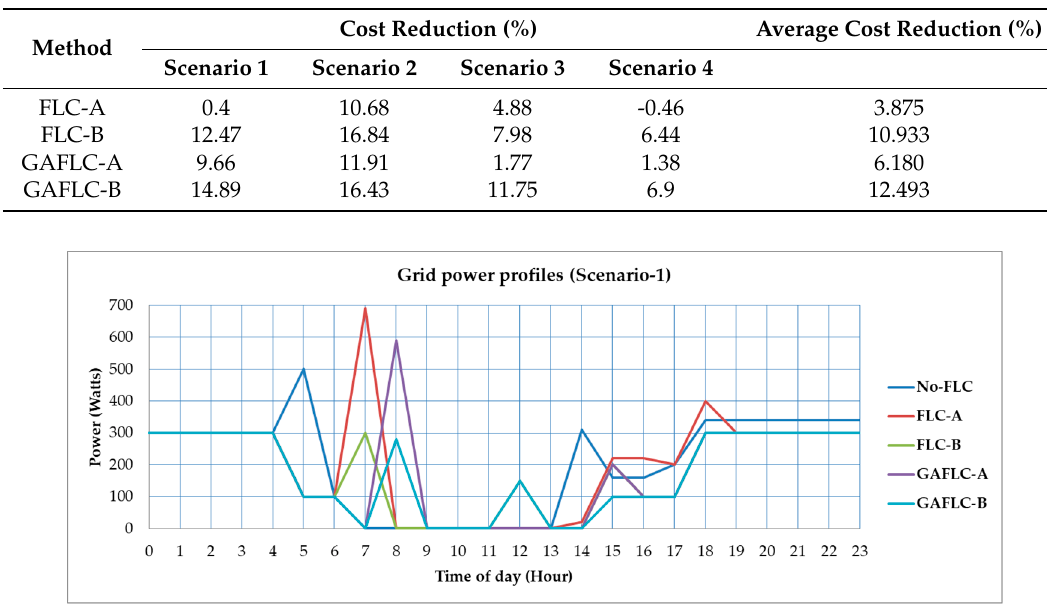
Figure 13. The grid power profiles in Scenario 1 (No-FLC, FLC-A, FLC-B, GAFLC-A, GAFLC-B).